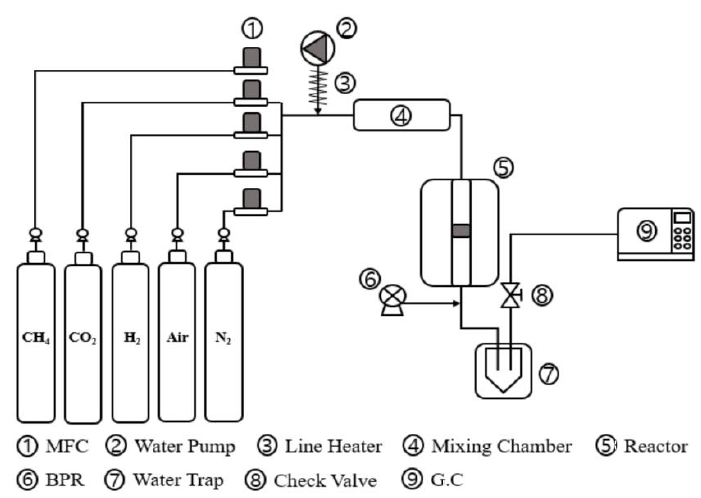
Figure 10. Schematic of CO 2 methanation.